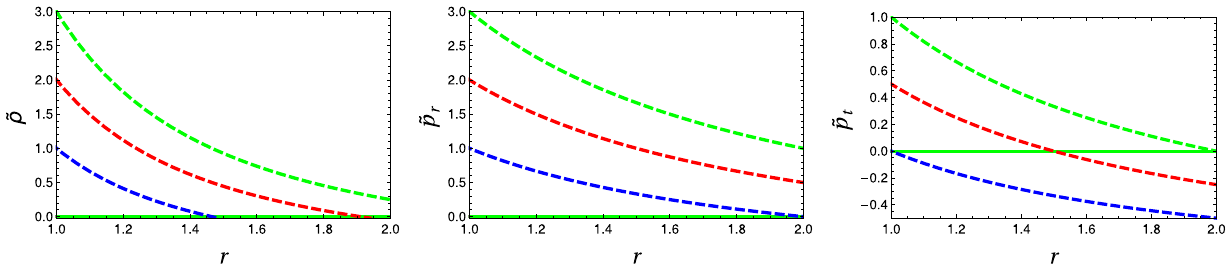
Fig. 2 Effective thermodynamics parameter as a function of the radial coordinate r taking as fixed values r 0 = 1 , A = 1 and n = − 1 for the following cases: (1) α = 0 and β = 1 . 0 (solid blue line), (2) α = 0 and β = 1 . 5 (solid red line), (3) α = 0 and β = 2 . 0 (solid green line),